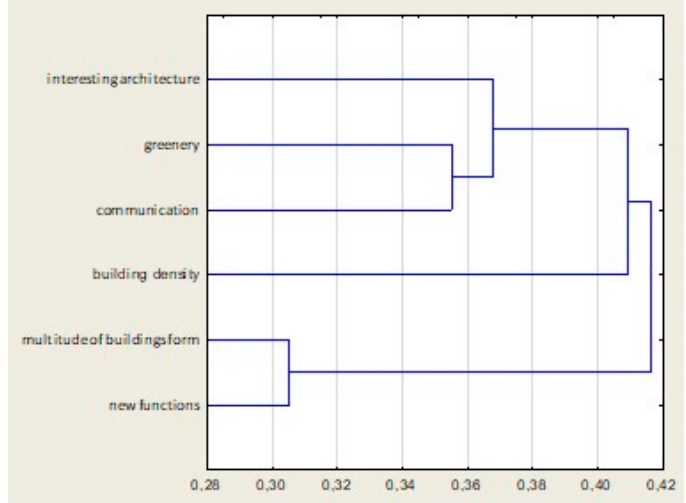
Figure 13. Grouping of characteristics in the perception of the urban landscape (EnvEng and CivEng students combined, n = 244).